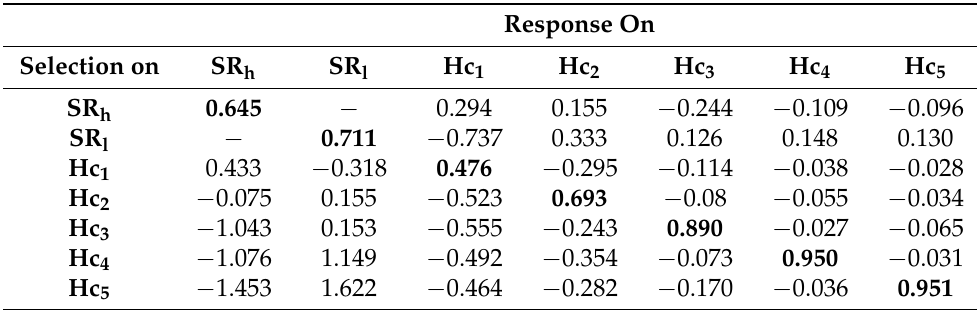
Table 9. True selection response 1 from the same trait (on diagonal and bold) and from different traits 2 (off diagonal) when all animals in the populations are genotyped ( n =